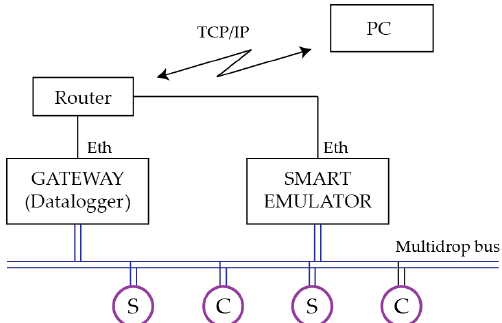
Figure 21. Platform architecture for increasing network adaptability and ensuring fault-tolerant behavior (S/C-sensor/controller node, Eth-Ethernet) [66].